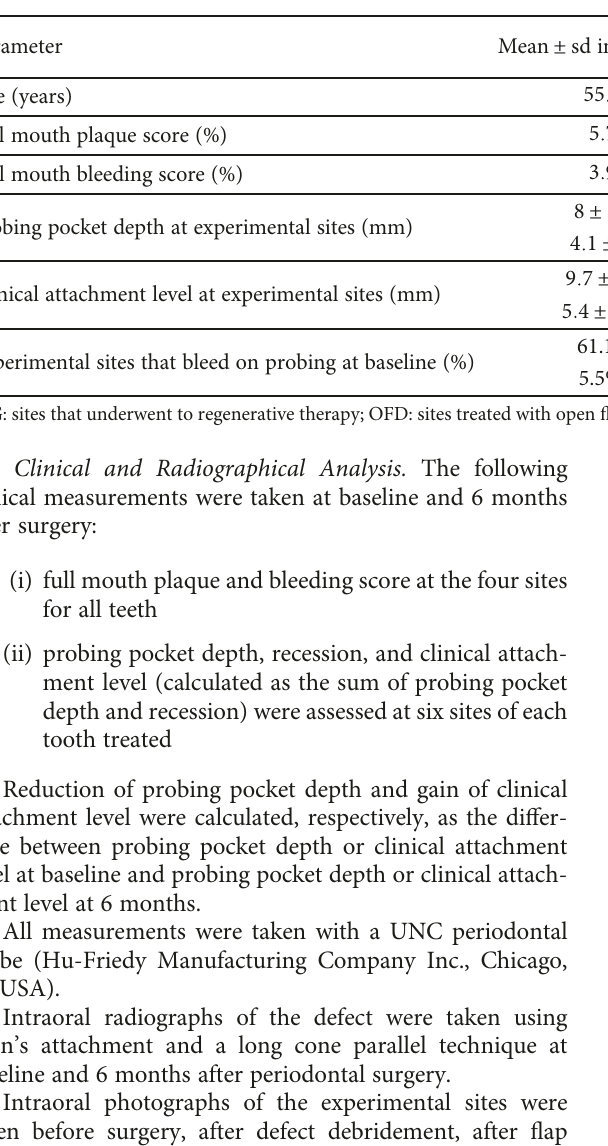
Table 1: Data on study